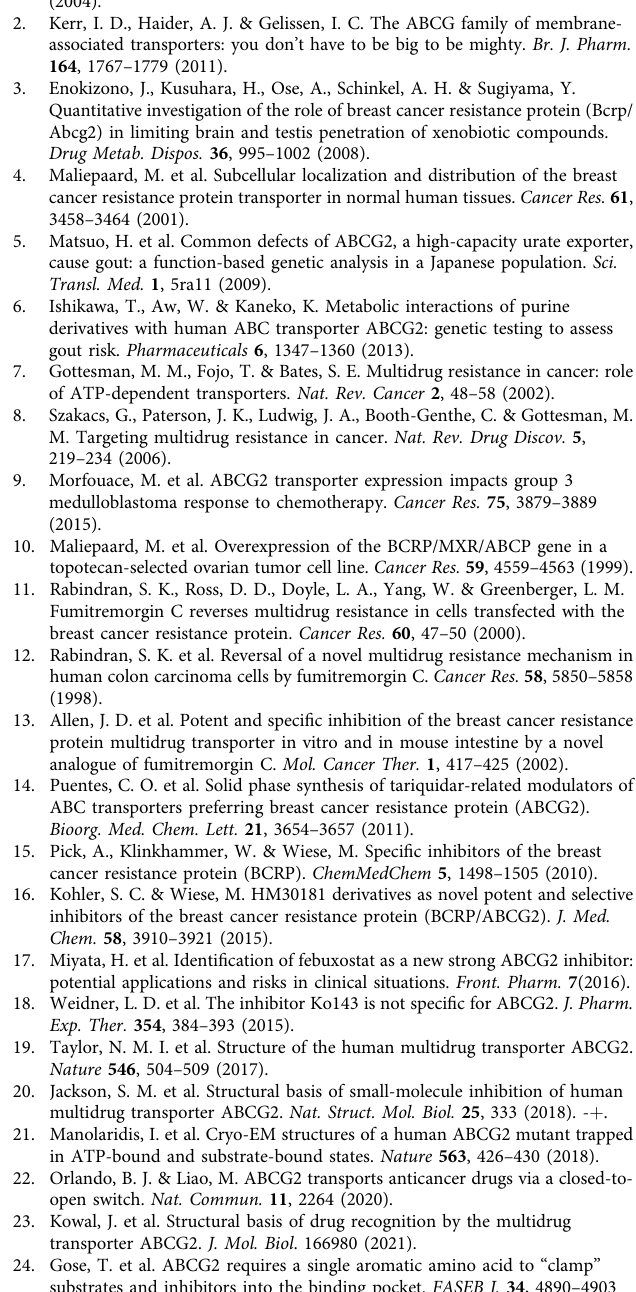
Figure preparation . Figures were prepared with PyMOL (The PyMOL Molecular Graphics System, Version 2.4.0 Schrödinger, LLC), GraphPad Prism v8, v9,